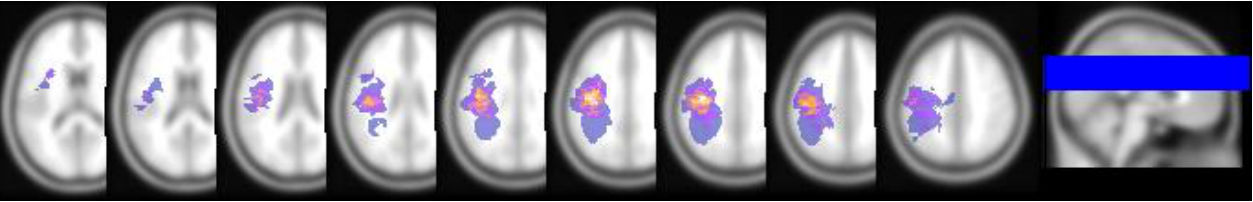
Figure 2. Normalized tumor overlap map. Overlapping map of all normalized tumor ROI. Voxel color indicates the number of overlapping cases, from 1 (blue-purple) to 12 (light yellow).